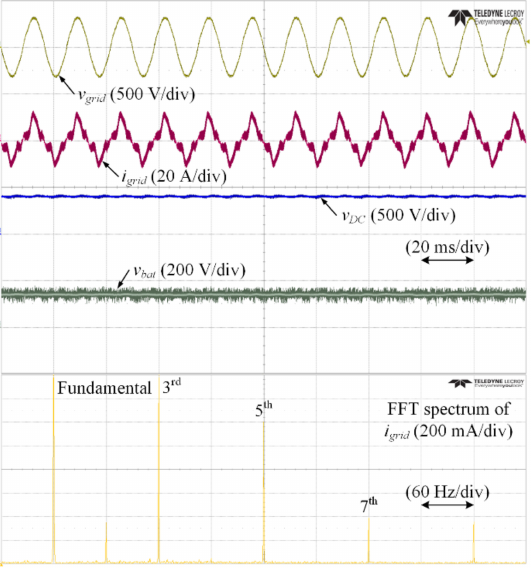
Figure 15. Experimental results of integrated OBC with fifth-order and seventh-order harmonic components in a single-phase grid